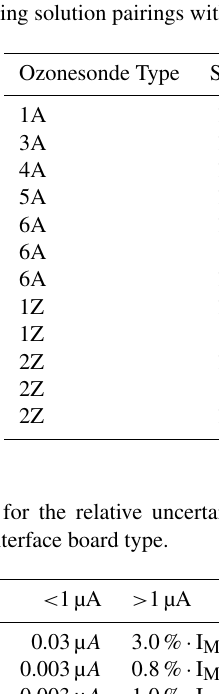
Table 3. Ozonesonde type–sensing solution pairings with corresponding ozone sensor efficiency.